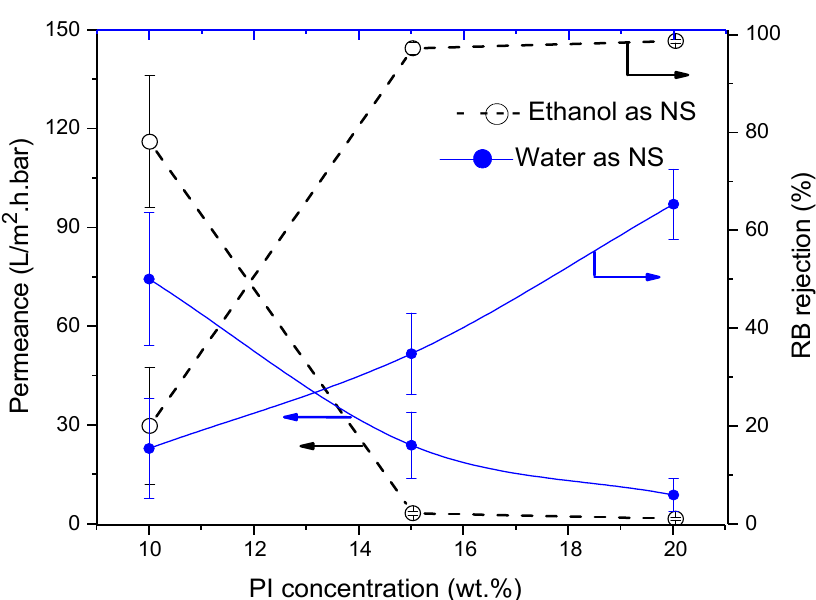
Figure 8. Influence of polyimide (PI) concentration on membrane performance in term of RB rejection and permeance. Striped lines represent membranes prepared using ethanol as non-solvent and full lines these with water as non-solvent.